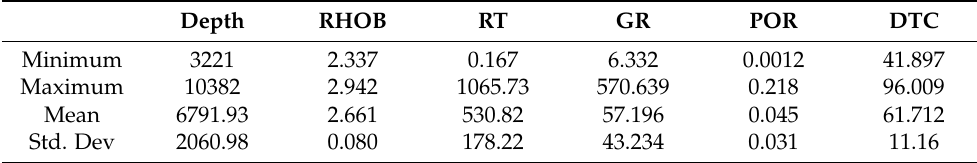
Table 2. Dataset information from P1 well (Total datapoint = 14,235).